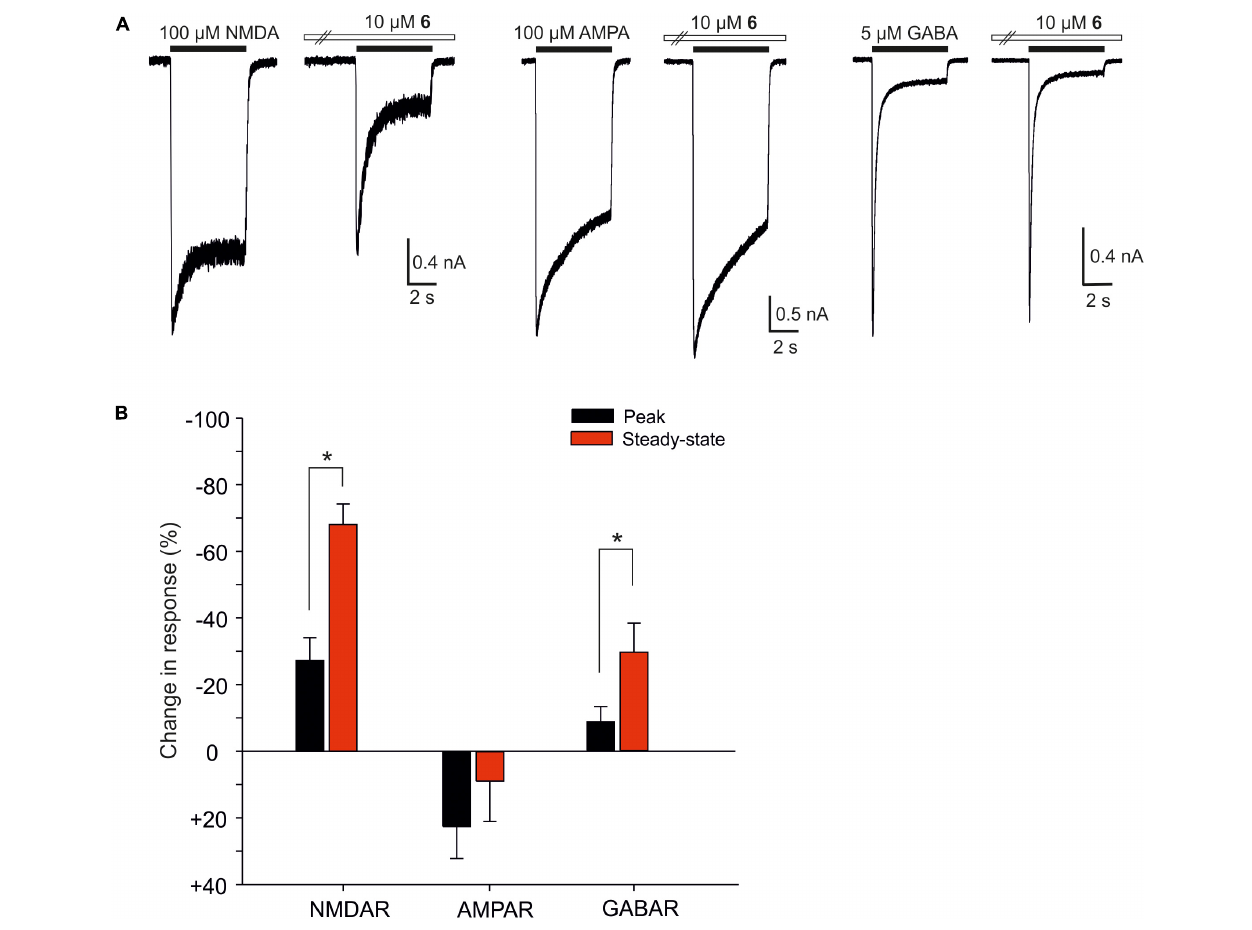
FIGURE 8 | The effect of compound 6 on peak and steady-state responses of native NMDARs, AMPARs, and GABARs. (A) Examples of traces obtained from cultured hippocampal neurons. Compound 6 (10 µ M) was pre-applied in the absence of agonists followed by co-application with NMDA (100 µ M), AMPA (100 µ M), and GABA (5 µ M) (duration of agonist and steroid application is indicated by filled and open bars, respectively). (B) Bar graph represents the mean values of relative changes in the peak (black columns) and steady-state (red columns) responses of native NMDARs, AMPARs, and GABARs recorded in the continuous presence of 10 µ M compound 6. Error bars represent SD from five independent measurements. Asterisks mark significance at the level of P < 0.05 (Paired t